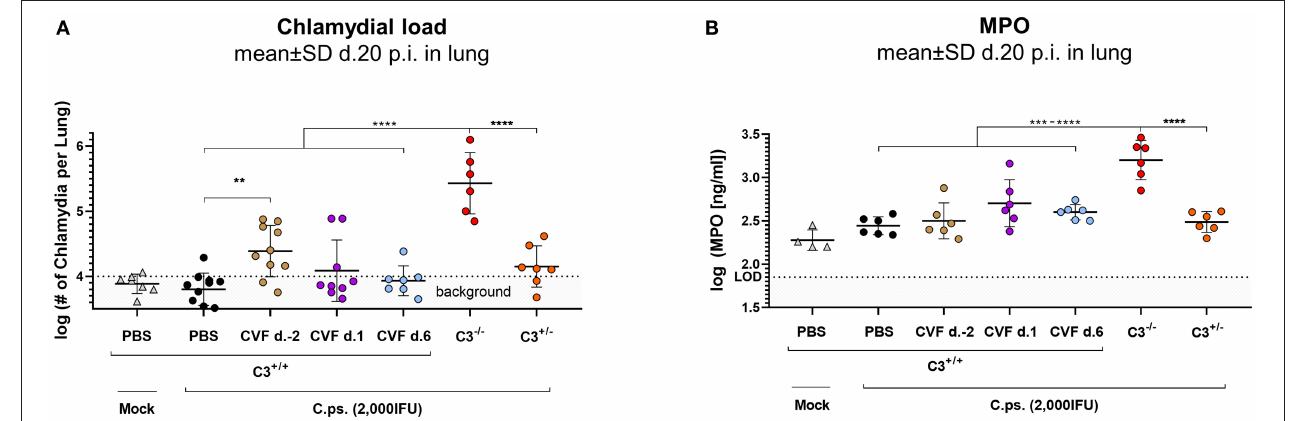
FIGURE 3 | WT-C3 levels of C3 + / + mice and presence of this central complement factor (for activation) during the first days of lung infection are required to provide optimal clearance of C. psittaci. The chlamydial load (A) and the level of the granulocyte marker MPO (B) were determined in the lung of mice 20 days p.i with 2,000 IFU of C.ps. or Mock material. Their complement was either transiently depleted by single application of CVF to C3 + / + , i.e., WT animals, as indicated (2 days before, or on day 1 or 6 after infection), or it showed different basal levels of C3 according to their genetic status as C3 + / + , C3 + / − , and C3 − / − C57BL/6J mice. The depicted results were combined from three or more, independent identical experiments. Statistical analysis was performed by One-way ANOVA followed by Bonferroni post-test. Statistical significance was displayed according to the calculated p -value: * p ≤ 0.0332; ** p ≤ 0.0021; *** p ≤ 0.0002; **** p ≤ 0.0001. d., day; LOD, limit of detection.